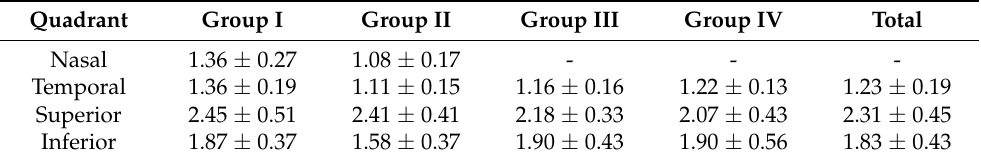
Table 2. Palisades of Vogt epithelial thickness (POV-ET)/Bowman ’ s membrane epithelial thickness (BM-ET) ratios of groups in each quadrant.